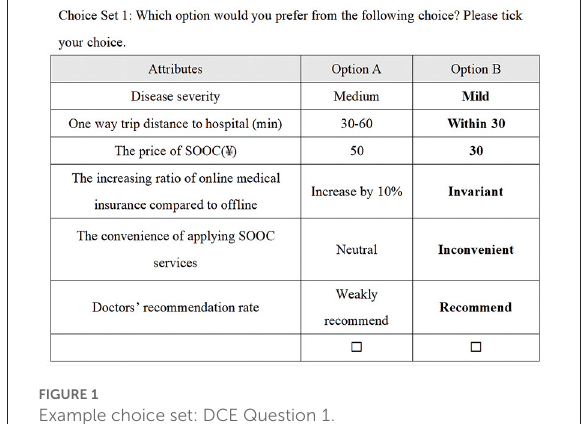
FIGURE1 Example choice set: DCE Question